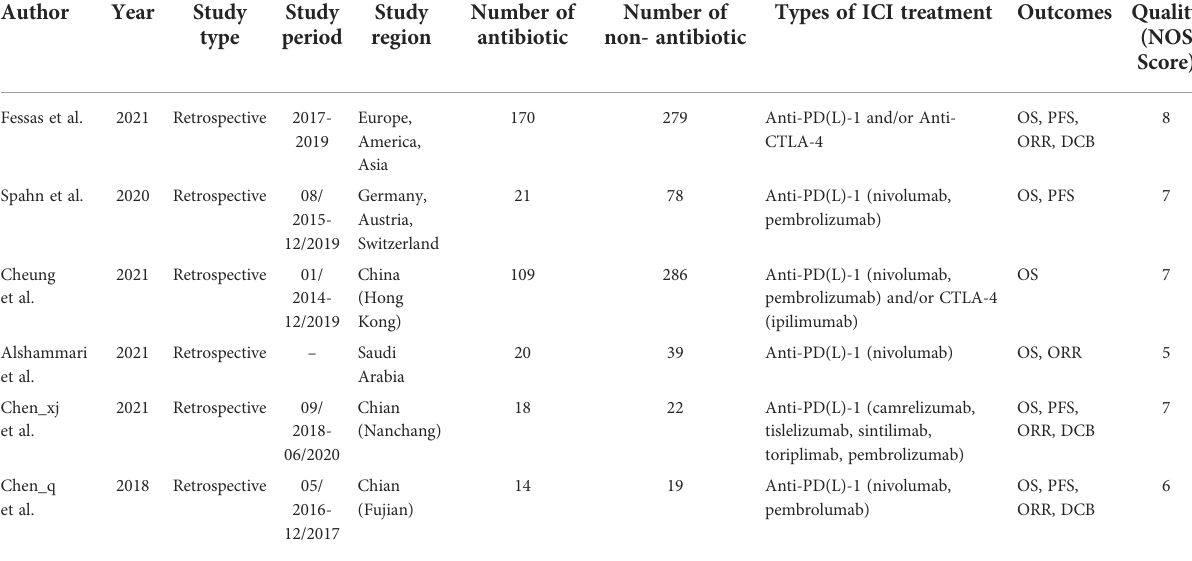
TABLE 1 Baseline characteristics of included studies.